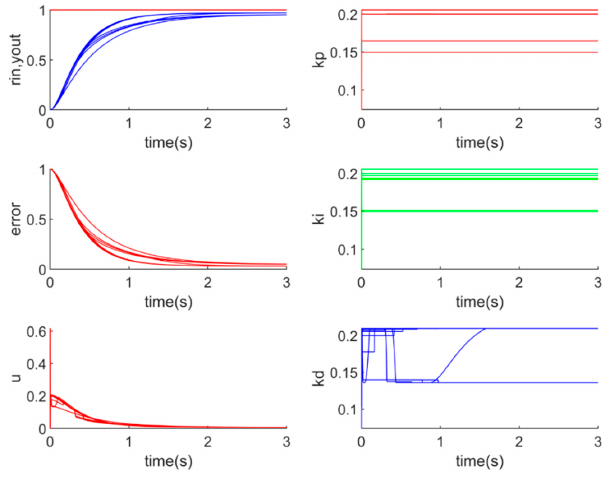
Figure 13. 10 SCs simulation for unstable RBFNN-PID-S systems.